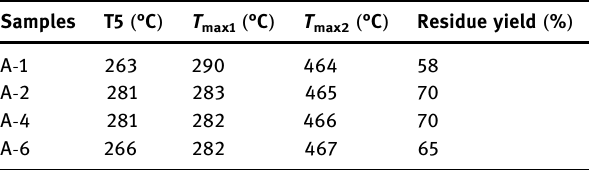
Table 2: Thermal decomposition parameters of composites